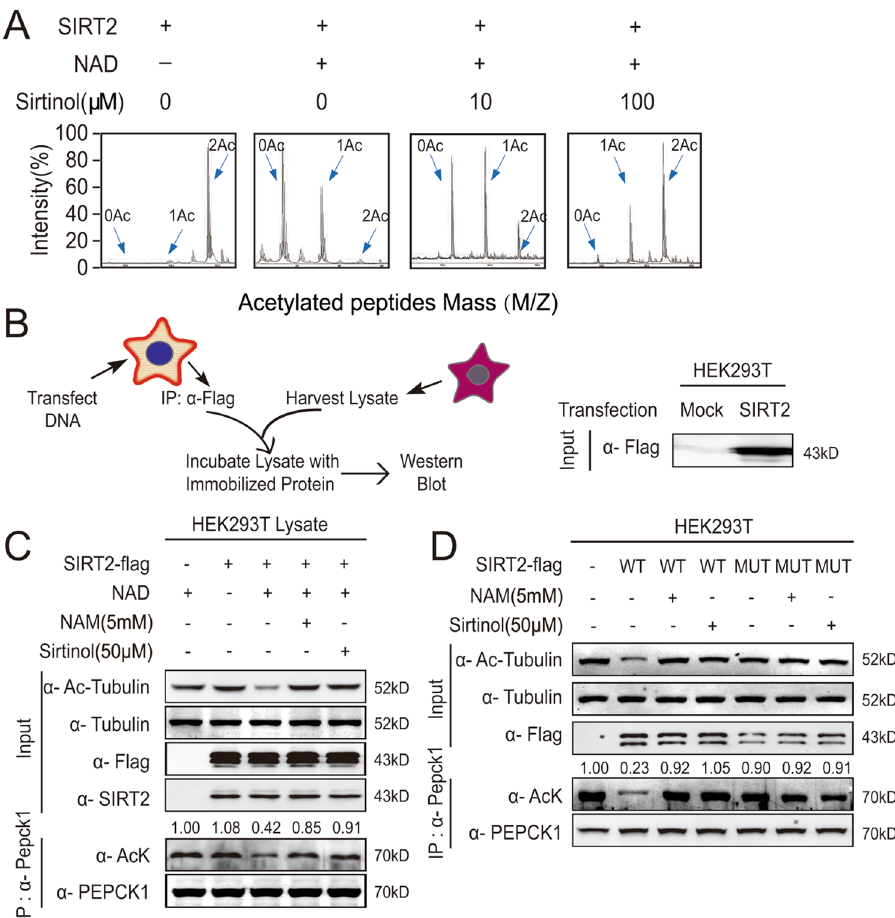
Figure 1. Sirtinol increases the acetylation of PEPCK1 by inhibiting the activity of SIRT2. ( A ) SIRT2 deacetylated toward PEPCK1 (K70, 71) acetylated peptides were assayed in the presence of increasing concentrations of sirtinol, as indicated. The deacetylated peptides were analyzed by MS are shown. ( B ) Schematic diagram of in vitro tubulin and PEPCK1 deacetylation assay (left). The visualized expression SIRT2 protein by Western blotting with specific anti-FLAG antibody are shown (right). ( C ) The immunoprecipitated protein corresponding to SIRT2-FLAG was incubated with cellular lysate with or without 1 mM NAD in vitro . Specified reactions were incubated with 5 mM nicotinamide or 50 μ M sirtinol. One half of reaction products were visualized by Western blotting with specific antibody (up). The other half of the immunoprecipitated material was incubated with PEPCK1 antibody and protein A agarose then washed and visualized by Western blotting with antibody for pan-acetylated protein and PEPCK1 (down). ( D ) HEK293T cells were transfected with flag tagged wild type or mutant SIRT2 (H187Y) plasmid for 36 hours, then treated with indicated 5 mM NAM or 50 μ M sirtinol for 4 hours. Cells were harvested and lysated. One half of lysates were visualized by Western blotting with specific antibody (up). The other half of the lysates were immunoprecipitated with flag- beads, then washed and visualized by Western blotting with antibody for pan-acetylated protein and PEPCK1